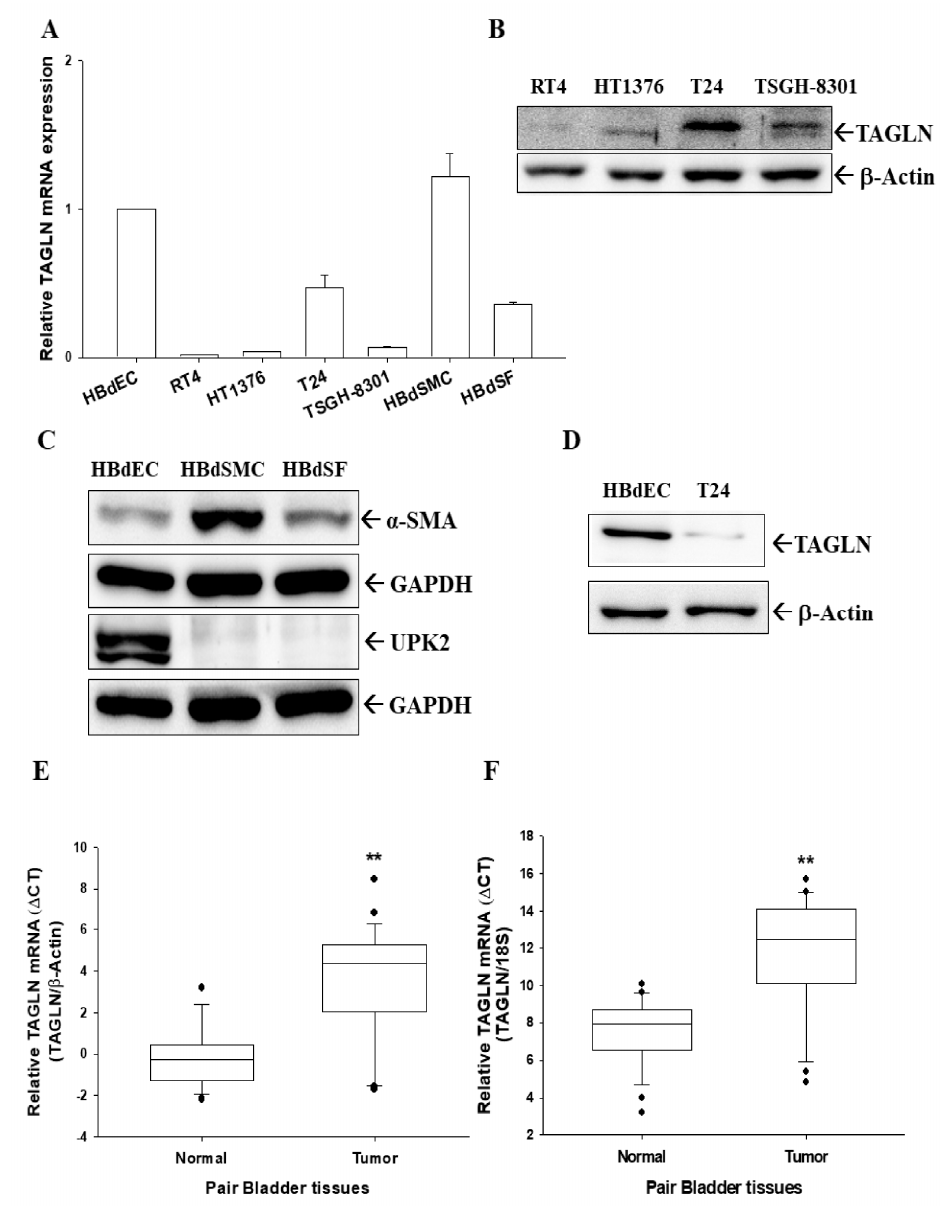
Figure 1. Gene expression of TAGLN in human bladder cells and tissues. ( A ) Total RNA from bladder smooth muscle cells (HBdSMC), fibroblast cells (HBdSF), normal epithelial cells (HBdEC), and carcinoma cell lines (RT4, HT1376, T24, and TSGH-8301) were extracted for RT-qPCR (± SE; n =